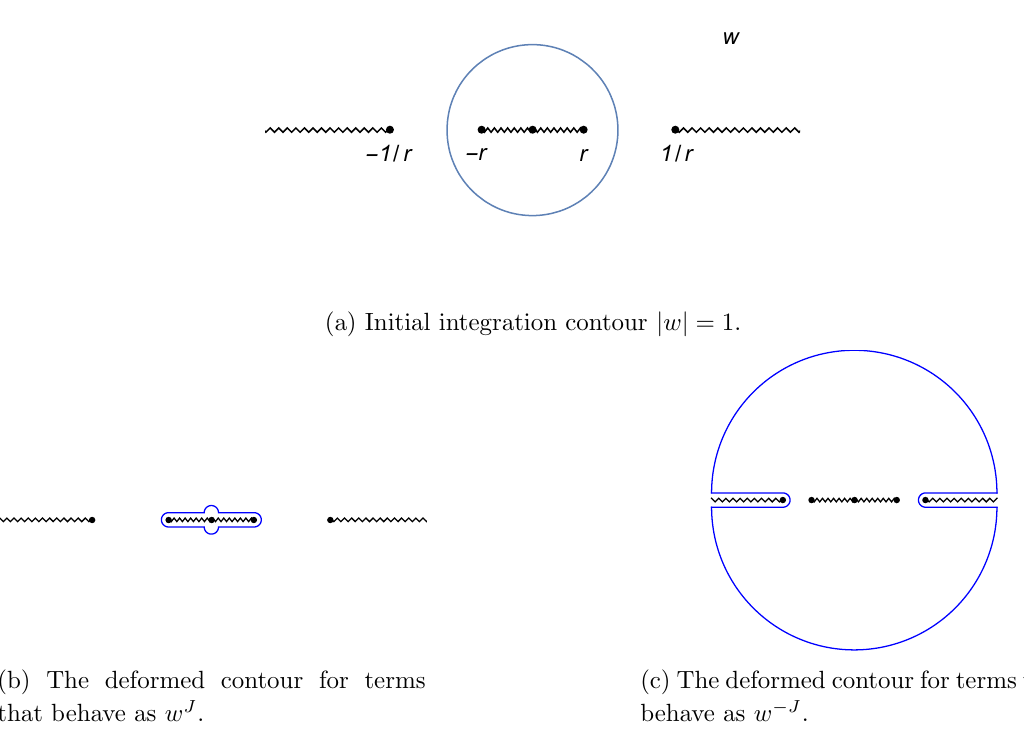
Figure 3. Contour manipulations for the inversion formula in the w plane. In (a) we show the original contour which lies along the circle j w j = 1. For the w J terms in (3.9), we deform the contour as in (b), and for the w (cid:0) J terms in (3.9), we deform the contour as in